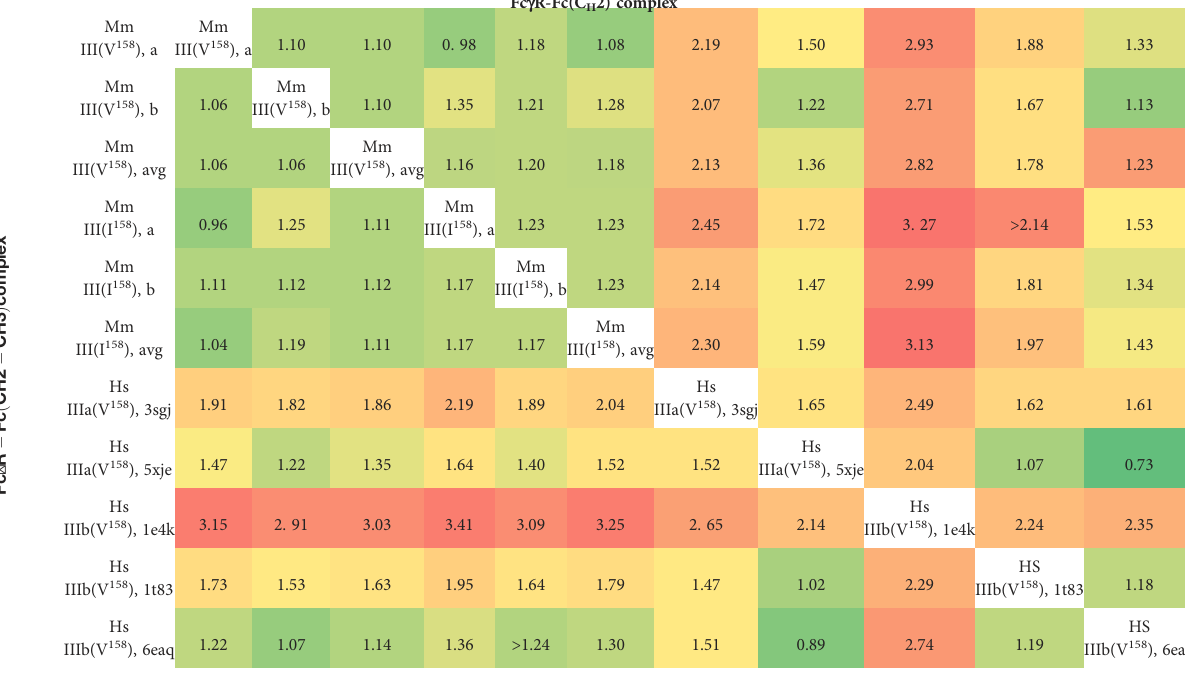
TABLE 3 Structural comparison of the macaque and human Fc g RIII-Fc(IgG1)